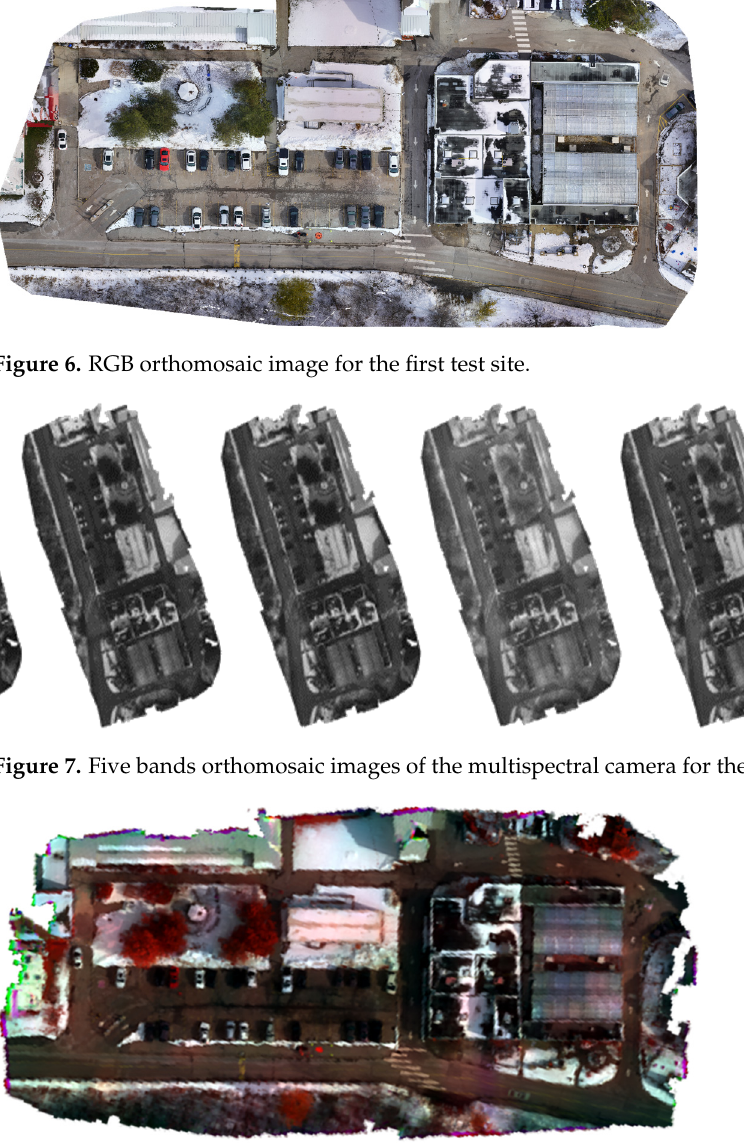
Figure 9. LiDAR SLAM trajectory for the first test site. Figure 10. LiDAR point cloud generated using SLAM for the first test site.